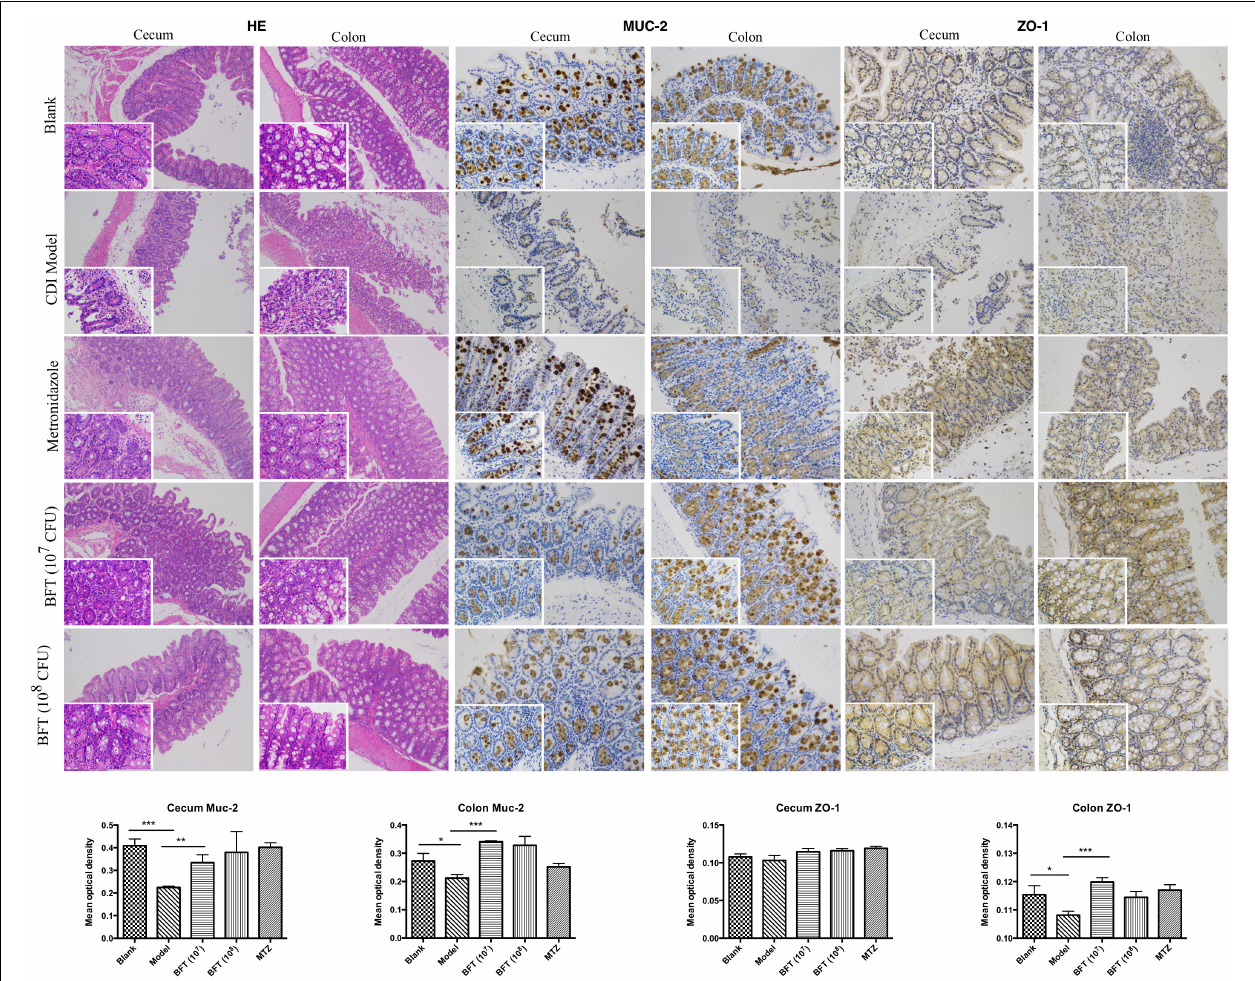
FIGURE 2 | B. fragilis ZY-312 improves gut barrier integrity and function in the CDI mouse model. Representative images of hematoxylin-eosin stained cecum and colon tissue samples from all groups are shown. Images showing representative immunohistochemical staining of Muc-2 and ZO-1 protein located in cecal and colon tissues in the Blank, CDI model, MTZ, and BFT groups are also shown. Mice in the Blank group were reared parallelly without any treatment. Mice in the CDI model group drank water with antibiotics including kanamycin (0.8 mg/mL), gentamicin (0.07 mg/mL), colistin (0.1135 mg/mL), metronidazole (0.43 mg/mL), and vancomycin (0.09 mg/mL) from D –9 to D –2, intraperitoneally injected with clindamycin (10 mg/kg) at D –1, and orally challenged with 3 × 10 8 cfu of C. difficile spores from D0 to D2. Mice in the MTZ group were treated with metronidazole (1 mg/day) from the day of C. difficile spore challenge (D0) to D5. Mice in the BFT groups were CDI model mice prophylactically treated with 1 × 10 7 or 1 × 10 8 cfu/day B. fragilis from the onset (D –9) to the end of CDI modeling (D2). Data of mean optical density are shown as means ± SEM. ∗ p < 0.05, ∗∗ p < 0.01, ∗∗∗ p < 0.001, by unpaired t